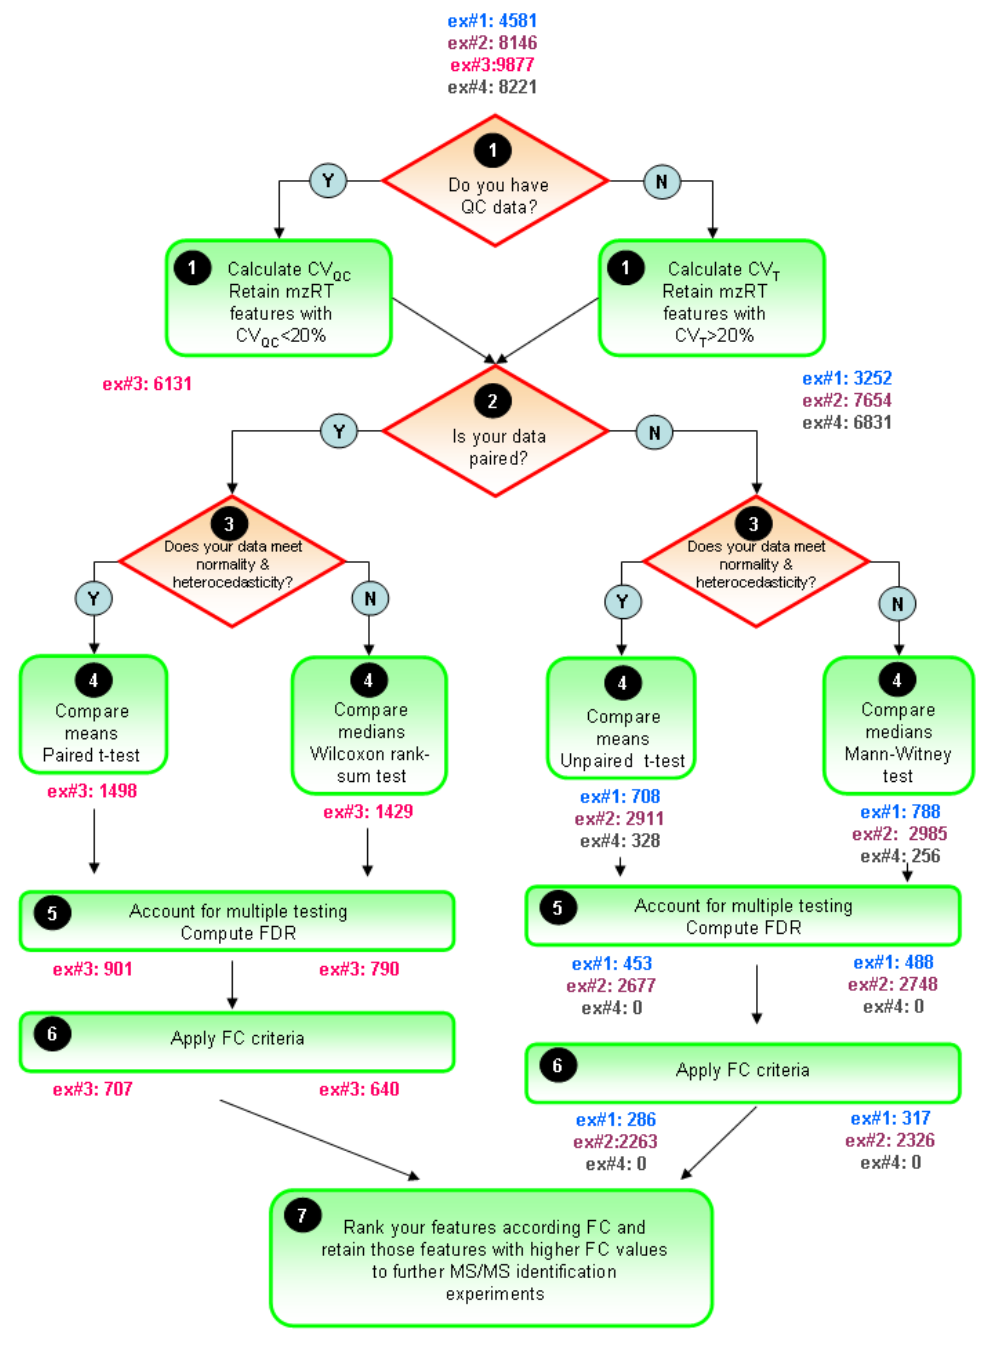
Figure 5. General flow chart for univariate data analysis of untargeted LC-MS-based metabolomics data. Different colors for the four working examples indicate the initial number and the retained number of mzRT features in each step. FDR and FC value are fixed at 5% level 1.5-cutoff values